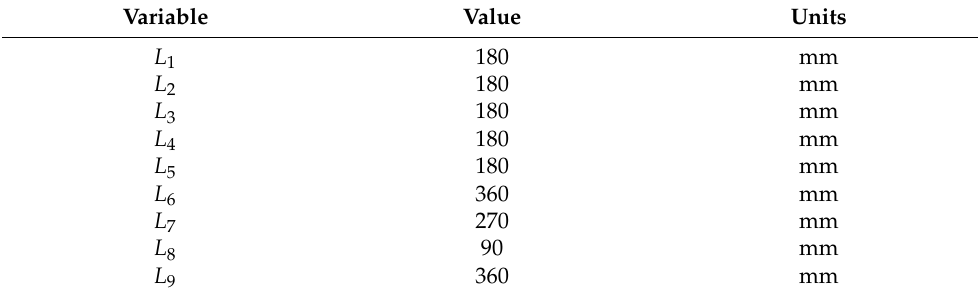
Table 5. Design parameters of the Nurse